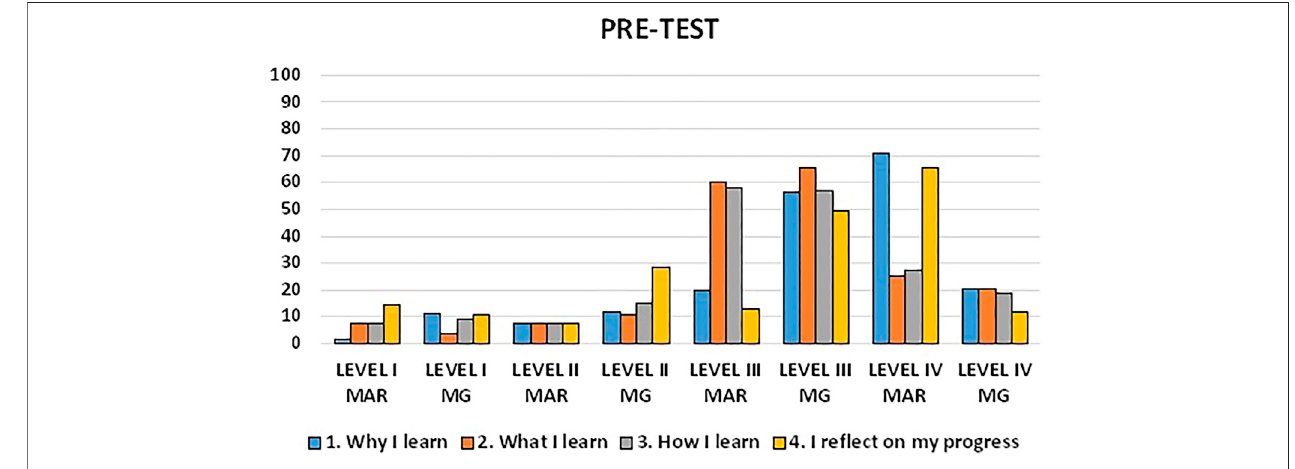
FIGURE 8 | MAR vs. MG (pretest): levels of achievement of the four dimensions.